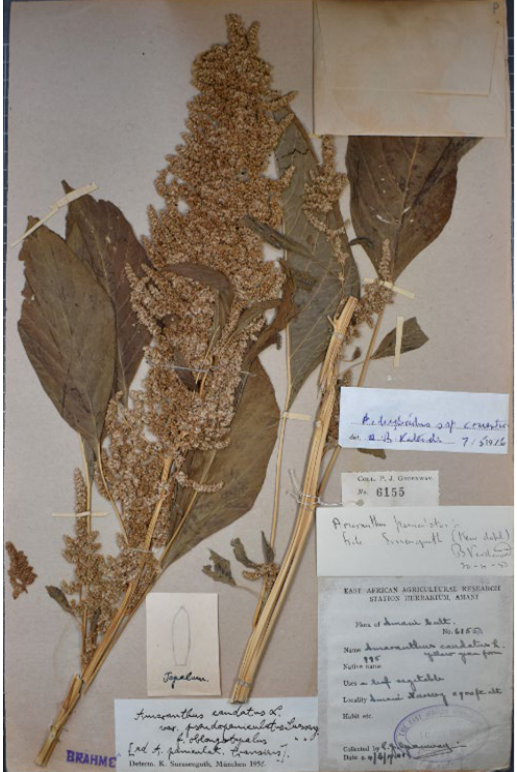
Figure 3. Holotype of Amaranthus caudatus var. pseudopaniculatus f. oblongipetalus (EA no. 6155).